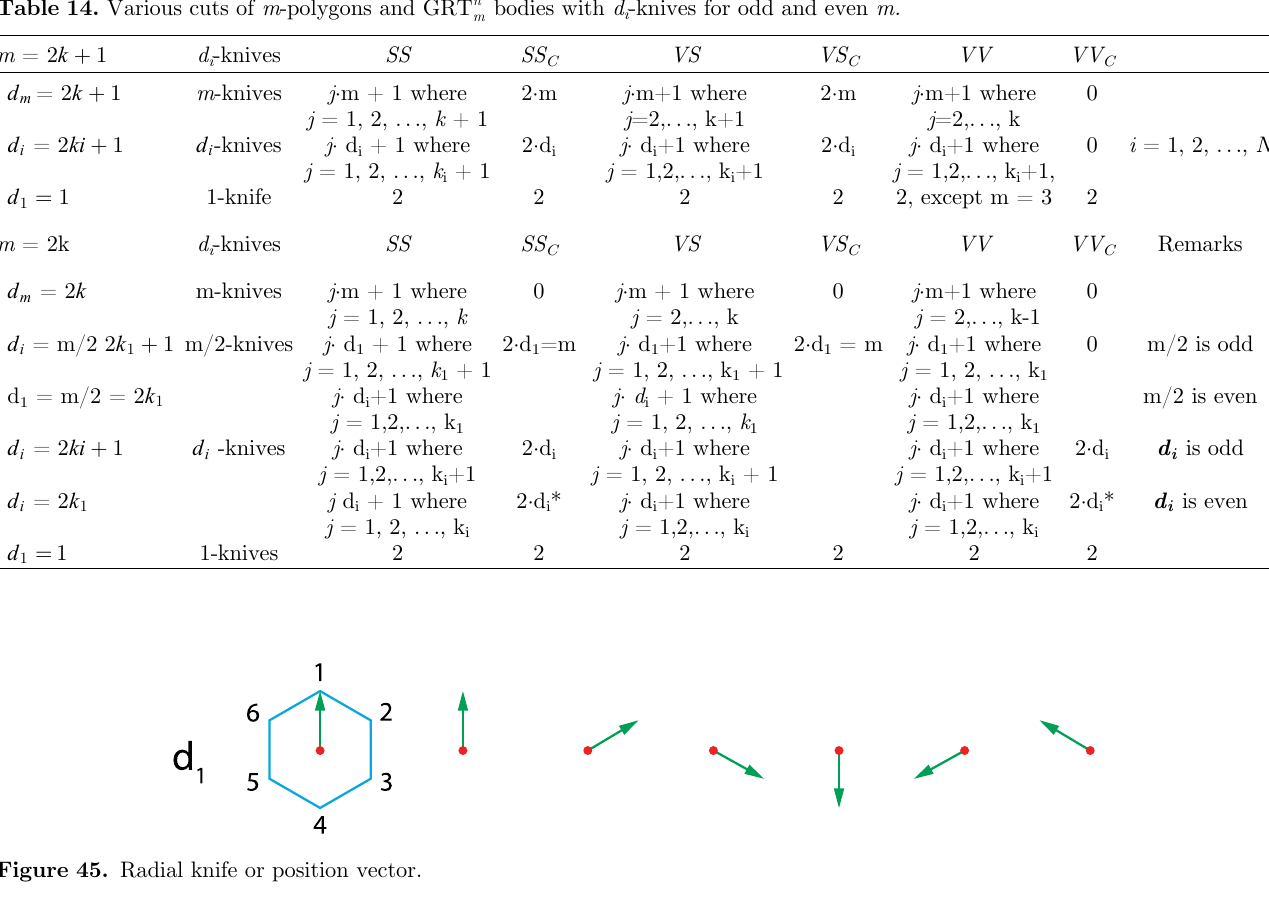
Figure 45. Radial knife or position